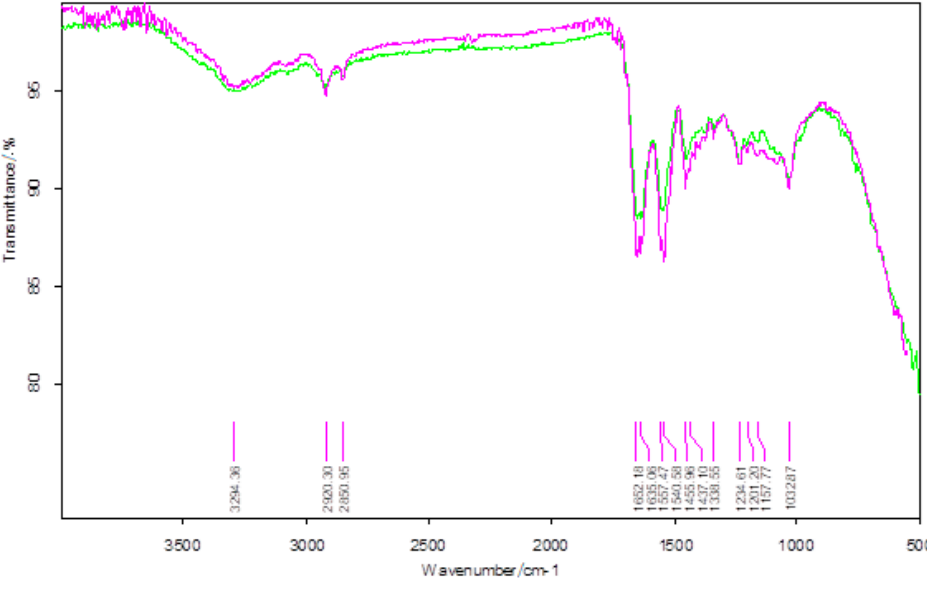
Table 15. Wavenumbers of infrared radiation absorption in the case of BPA.